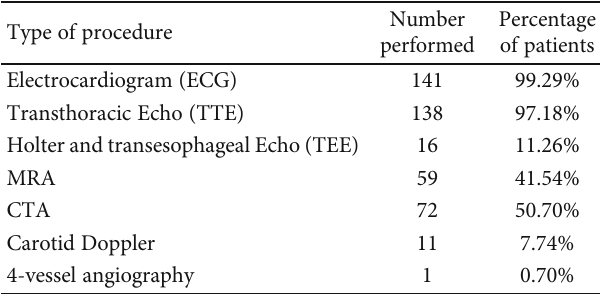
Table 2: Frequency of procedures performed under stroke work-up (Note: numbers are not mutually